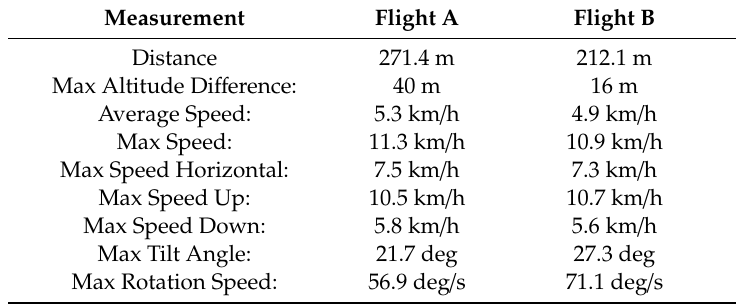
Table 3. Experimental results of the di ff erent localization methods evaluated for flights A and B. Measurement Flight A Flight B Distance 271.4 m 212.1 m Max Altitude Di ff erence: Average